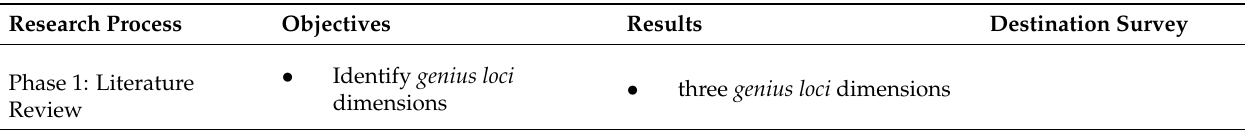
Table 2. Overview of the research process